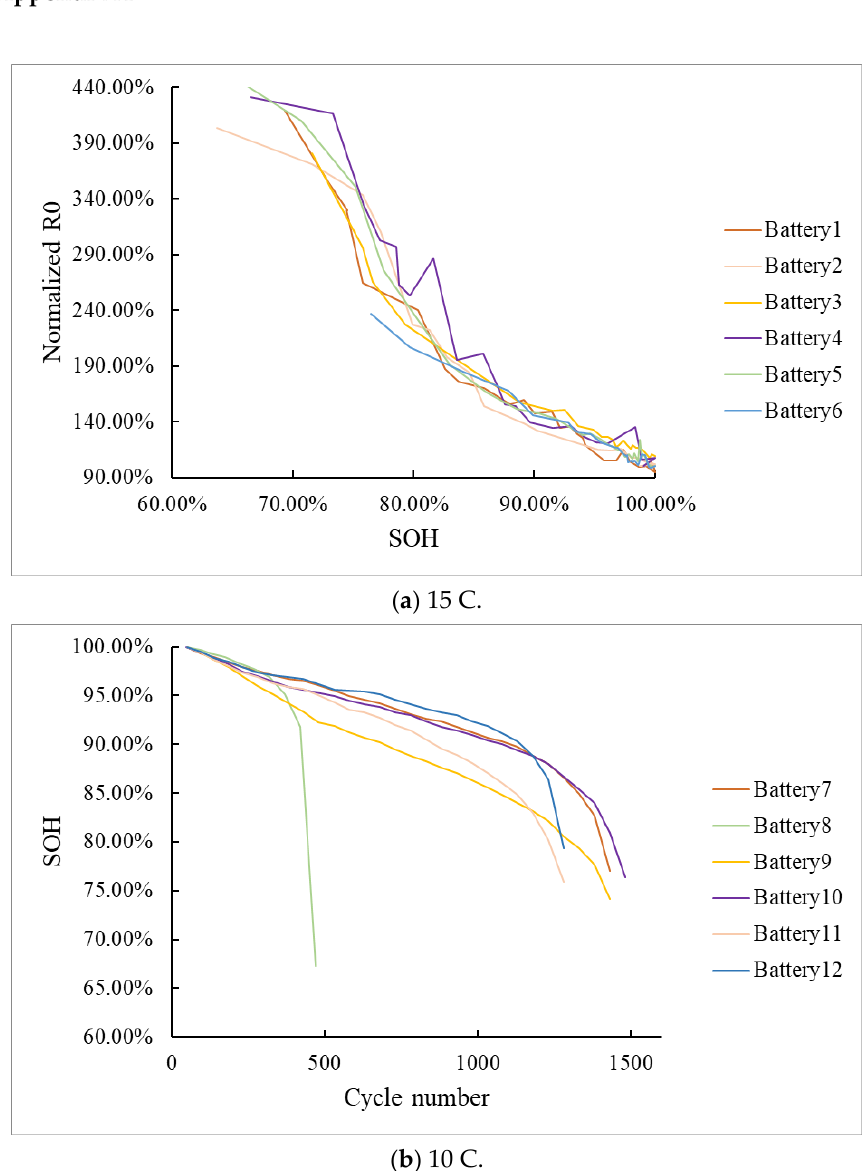
Figure A1. The relationship between the SOH and cycle number.